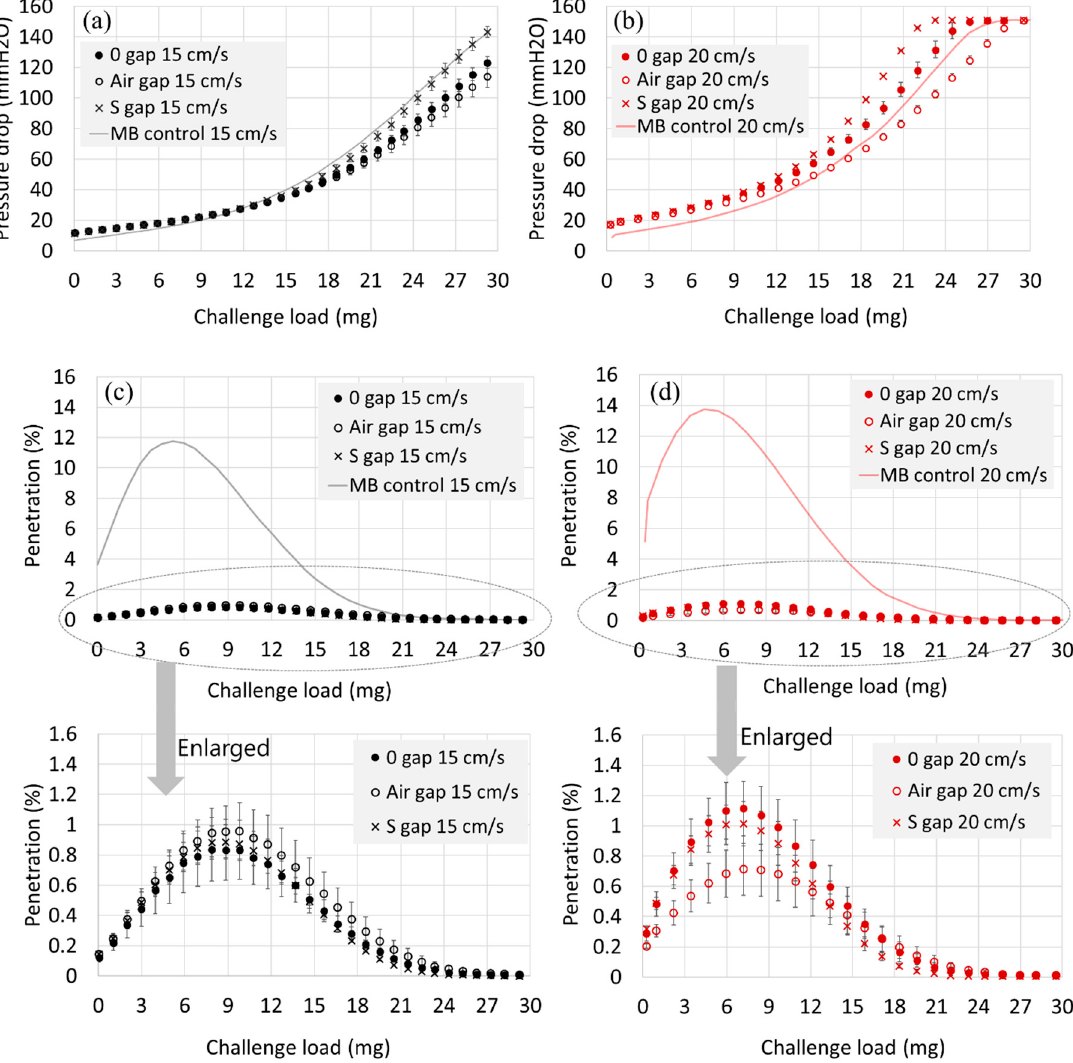
Figure 4. Pressure drop and penetration development for 2-layer constructions during 30 mg of NaCl loading. ( a ) Pressure drop at 15 cm/s, ( b ) Pressure drop at 20 cm/s, ( c ) Penetration at 15 cm/s, ( d ) Penetration at 20 cm/s. Note. For a single layer of spacer web, Pn (%) remained >99.5% and dP (mm H 2 O) remained <0.5 mm H 2 O throughout the loading.